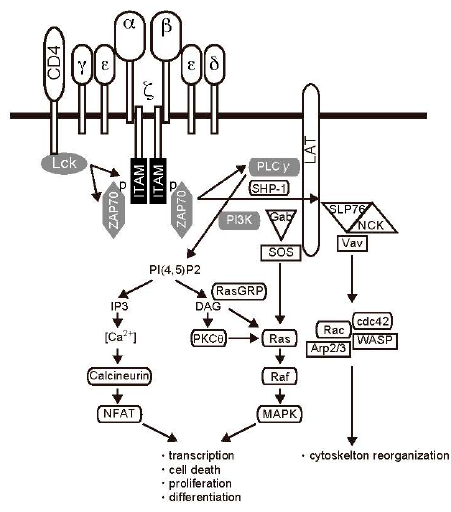
Figure 1. TCR signaling. Signaling is initiated by engagement of the T-cell receptor. Formation of the signaling complex coordinates numerous second messenger and kinase cascades, leading to transcriptional activation and cytoskeletal reorganization.